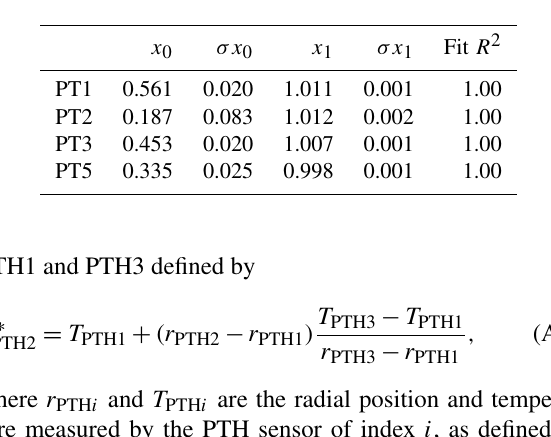
Table A4. Fitted calibration parameters and 1 standard deviation uncertainties for the Pt100 string during the calibration